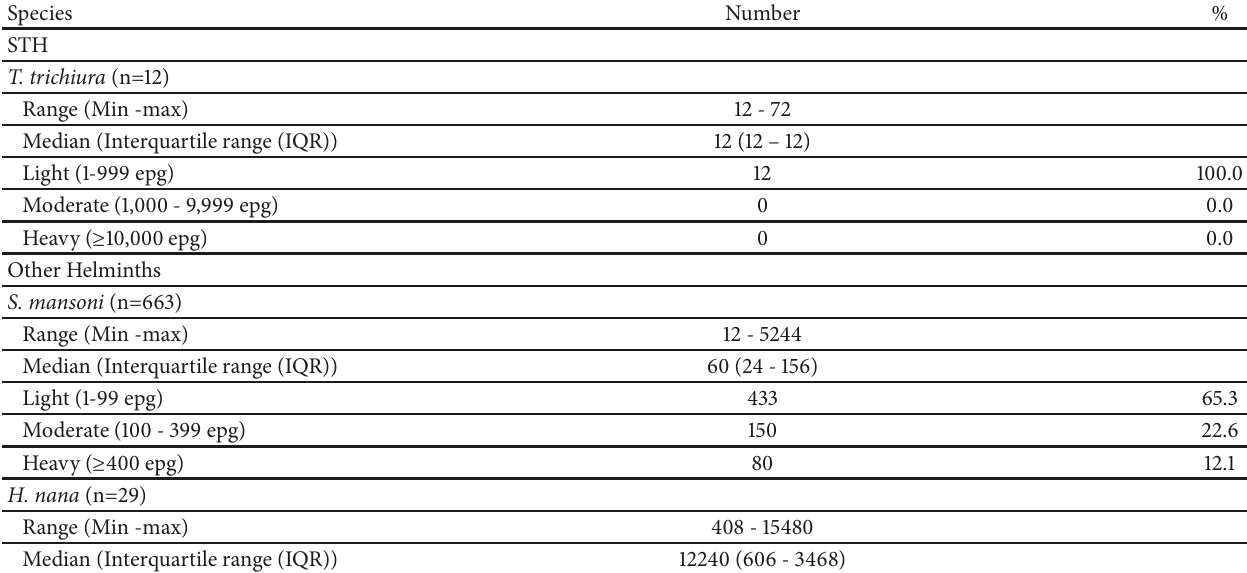
Table 4: Intensity of STH and other